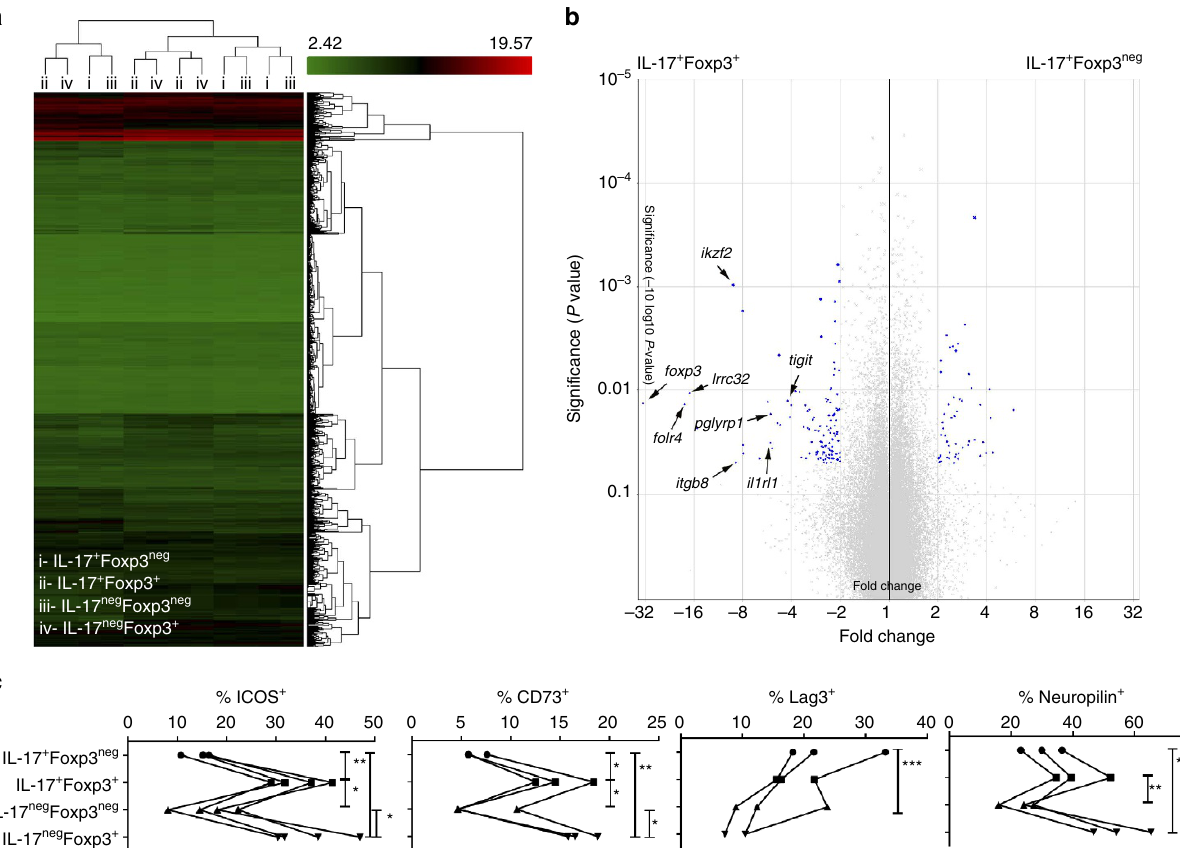
Figure 6 | Transcriptome analysis of IL-17A þ Foxp3 þ /neg cells. ( a – c ) Foxp3 neg IL-17A þ (i), Foxp3 þ IL-17A þ (ii), Foxp3 neg IL-17A neg (iii) and Foxp3 þ IL-17A neg (iv) CD3 þ Tcells were sorted using the strategy presented in Fig. 3a. ( a ) Heat map from hierarchical clustering of differentially expressed genes ( n ¼ 3 per subset). ( b ) Volcano plot demonstrates increase in defined transmembrane markers ( Tigit , Tmem154 , Folr4, Iikzf2 , Pglyrp1 , Cd86 , Lrrc32 , Il1rl1 , Itgb8 ) in Foxp3 þ IL-17A þ cells compared with Foxp3 neg IL-17A þ Tcells. ( c ) Cumulative data of flow cytometric staining (ICOS, CD73, Lag3, neuropilin1) of Th17-T reg subsets (i–iv) from three independent experiments. Additional data (TIGIT, ST2, Folr4, GARP, PGLYRP1) and representative flow cytometric staining are presented in Supplementary Fig. 7. All data are mean ± s.d. * P o 0.05, ** P o 0.01 and *** P o 0.001 by one-way analysis of variance